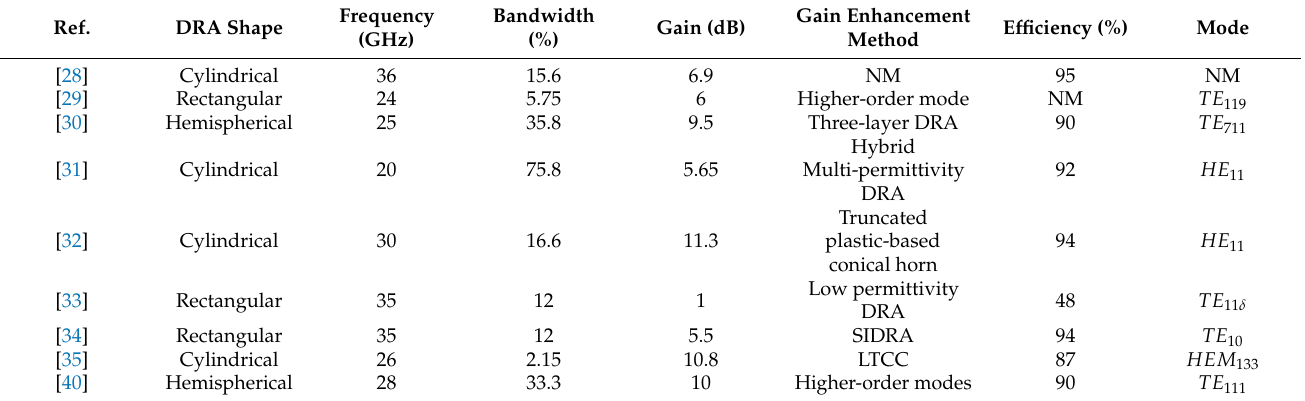
Table 1. Comparison between the performance of single linear polarized DRAs at